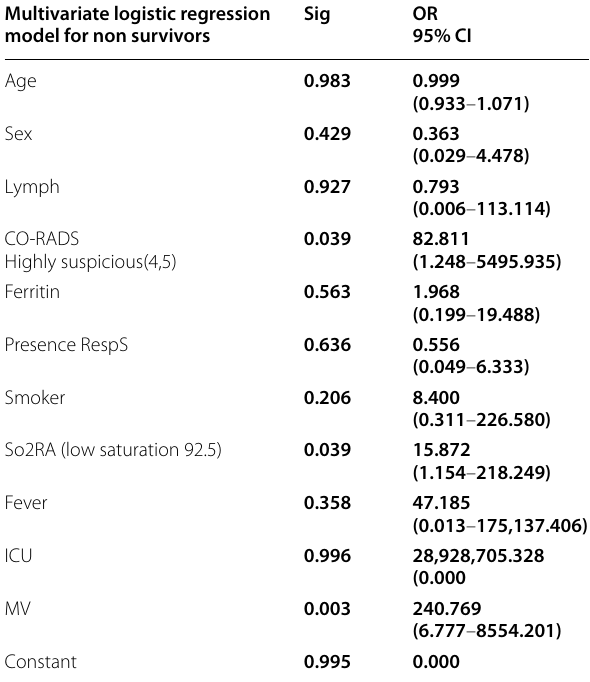
Table 4 Multivariate logistic regression model for prediction of mortality Multivariate logistic regression model for non